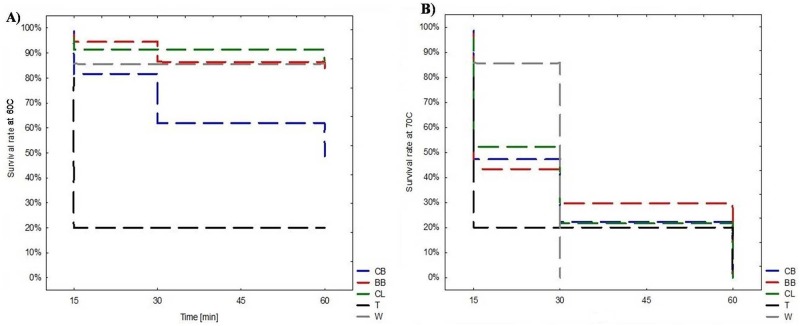
Survival skills of clinical E. cecorum isolates.(CB—Commercial Broiler Chickens; BB—Broilers Breeders; CL—Commercial Layers; T—Turkeys; W—Waterfowl) after treatment with: A) 60°C for 15min, 30 min, 1 h; and B) 70°C for 15min, 30 min, 1 h.